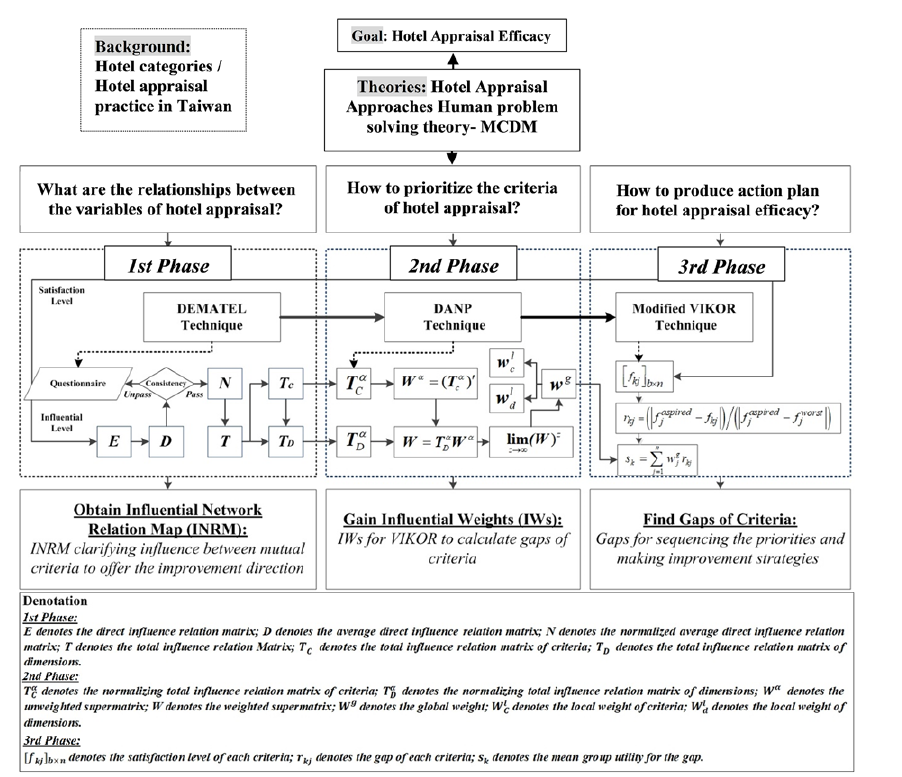
Figure 2. Conceptual framework and research layout and procedures of